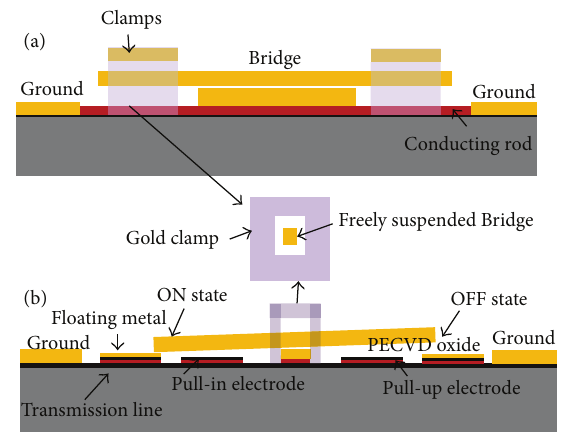
Figure 3: Cross-sectional view of working the SPDT switch (a) across AA 󸀠 and (b) across BB 󸀠 .